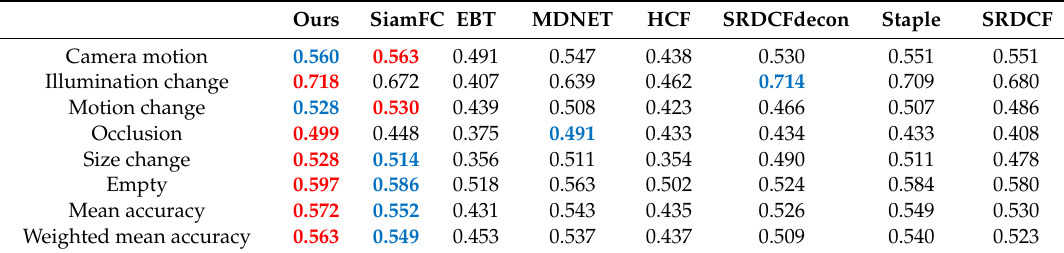
Table 4. Accuracy evaluation of ours and seven other state-of-the-art trackers on di ff erent challenging attributes of the VOT 2016 benchmark database. The best two results are marked in red and blue bold fonts, respectively.